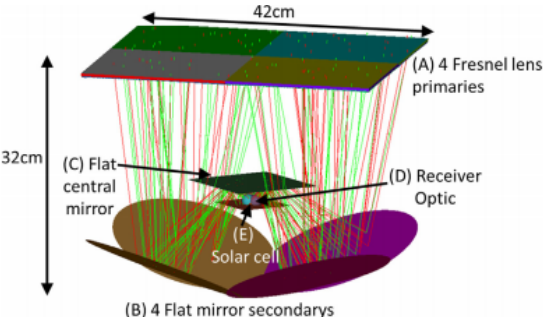
Figure 27. Solar concentrator composed of four Fresnel lenses and four flat mirrors proposed by Shanks et al. [3]. Reprinted from K. Shanks et al., A > 3000 Suns high concentrator photovoltaic design based on multiple Fresnel lens primaries focusing to one central solar cell, Solar Energy 2018, 169, 457–467, with permission from Elsevier.